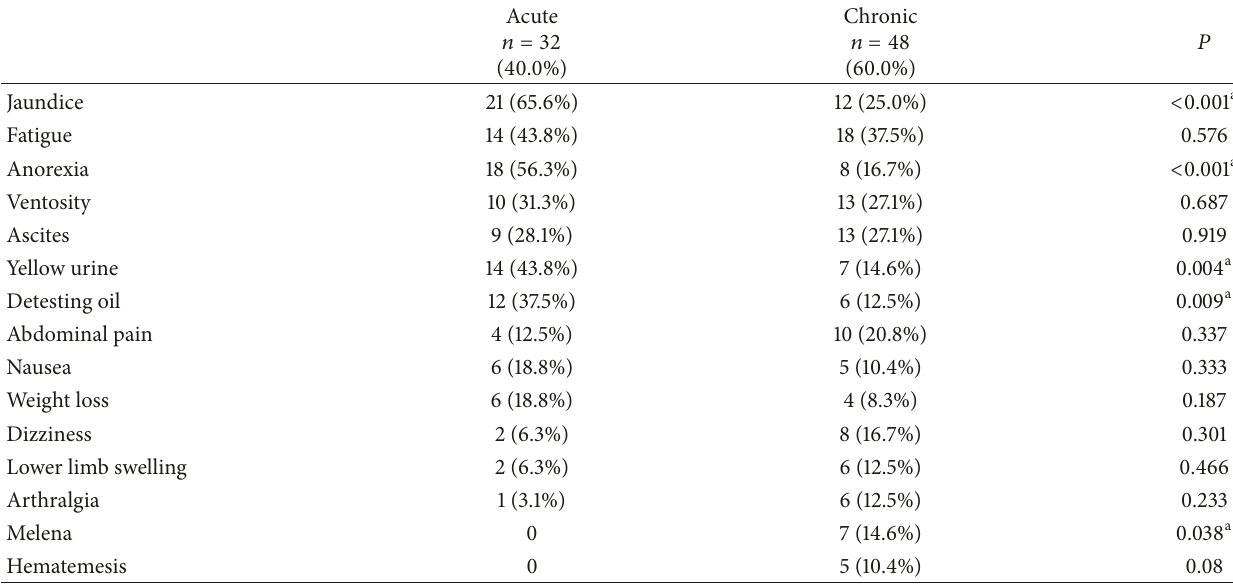
Table 5: Comparison of symptoms between A-AIH and C-AIH.